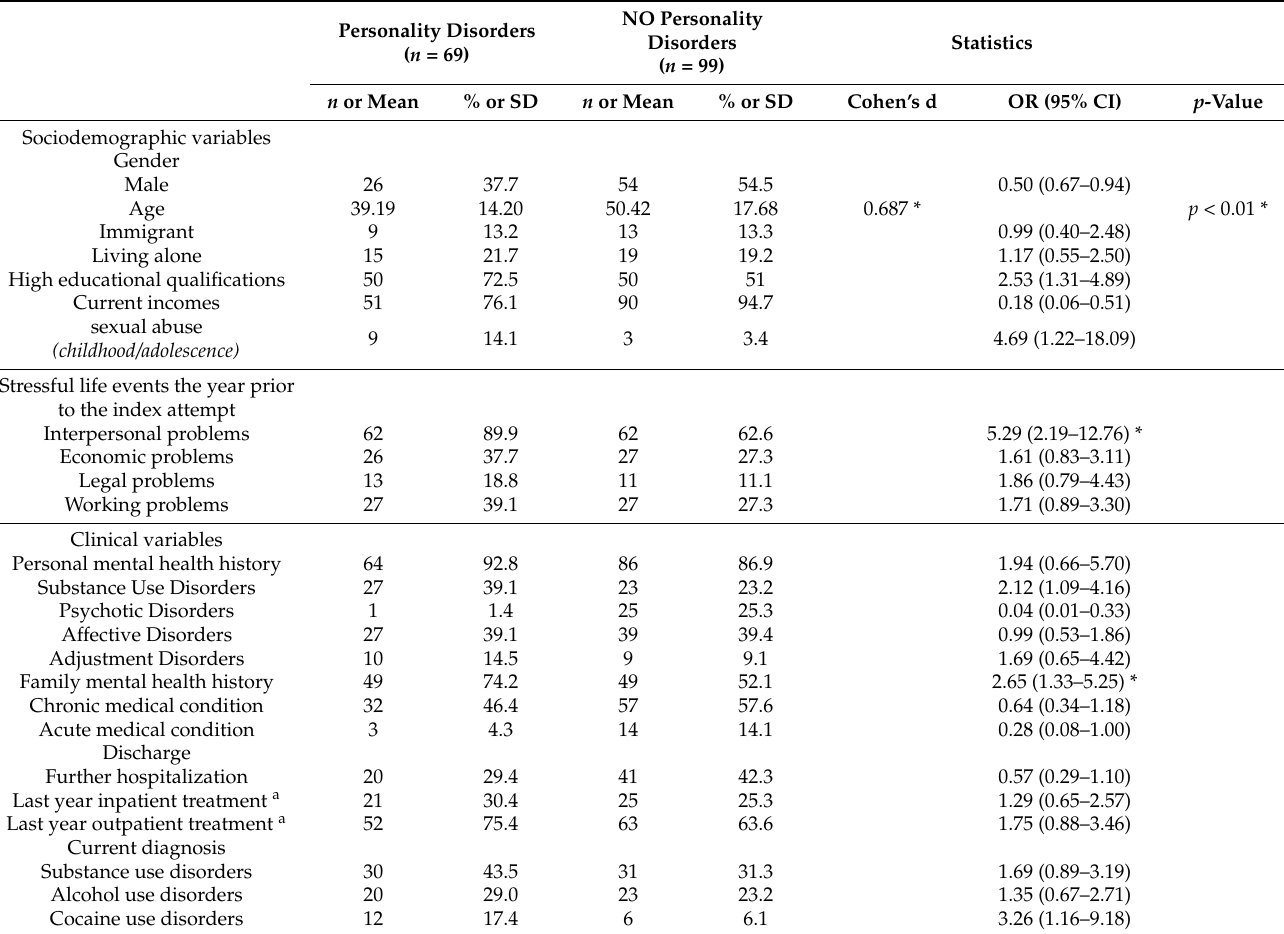
Table 1. Comparison of sociodemographic and clinical variables between SSA patients with and without personality disorders. NO Personality Personality Disorders Disorders ( n = 69) ( n = 99)